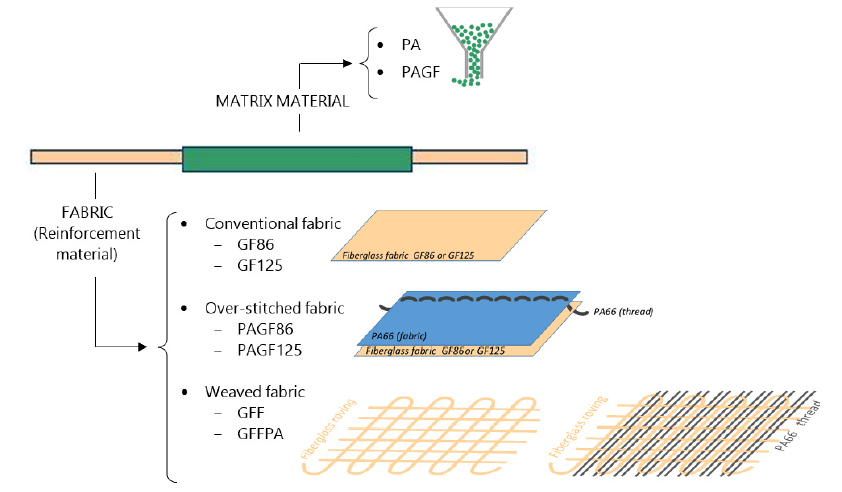
Figure 5. Explanatory diagram of the composition of the samples.